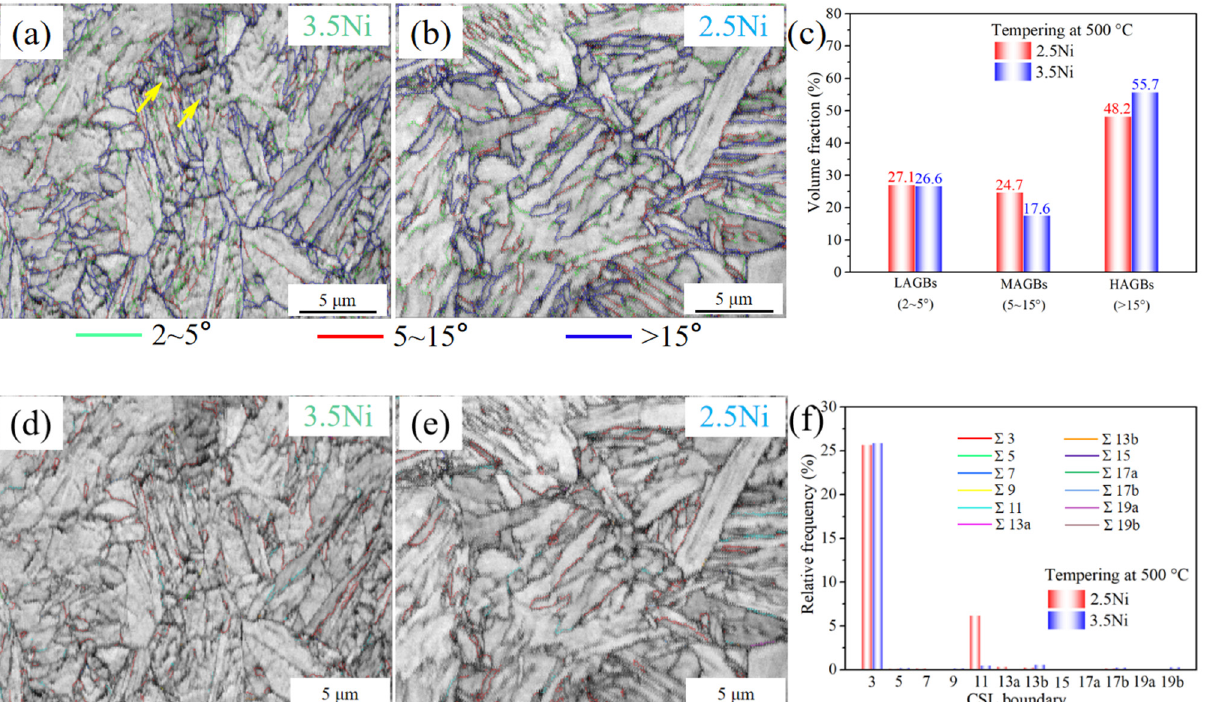
Figure 12. EBSD crystallographic analyses of both steels. ( a , b ) Misorientation distributions of grain boundaries. ( c ) Volume fraction of each grain boundary in the samples. ( d , e ) Reconstructed CSL boundary maps. ( f ) The frequency of each CSL boundary in the samples.